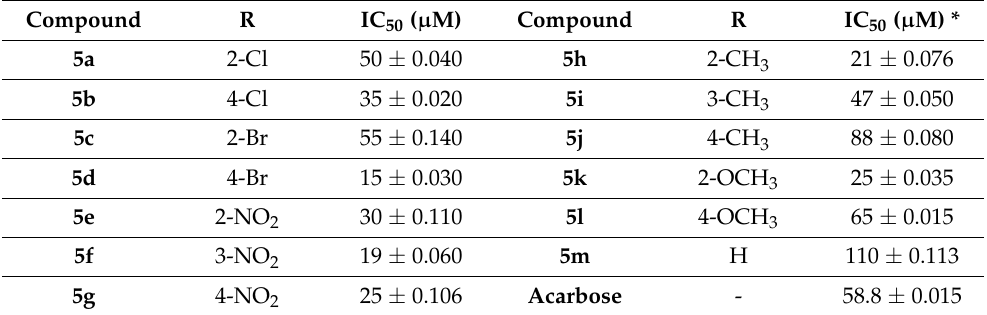
Table 2. In vitro α -glucosidase inhibition (IC 50 ) of synthesized benzimidazolium salts 5a – m